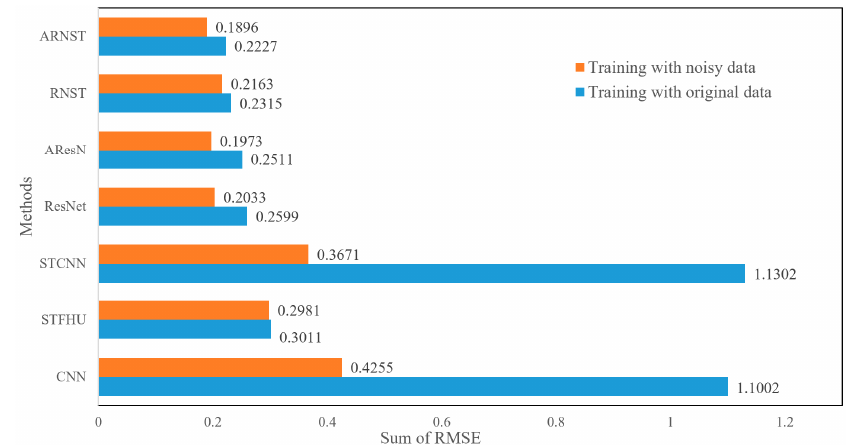
Figure 9. Performance comparisons of hyperspectral unmixing training with the original data and noisy data.